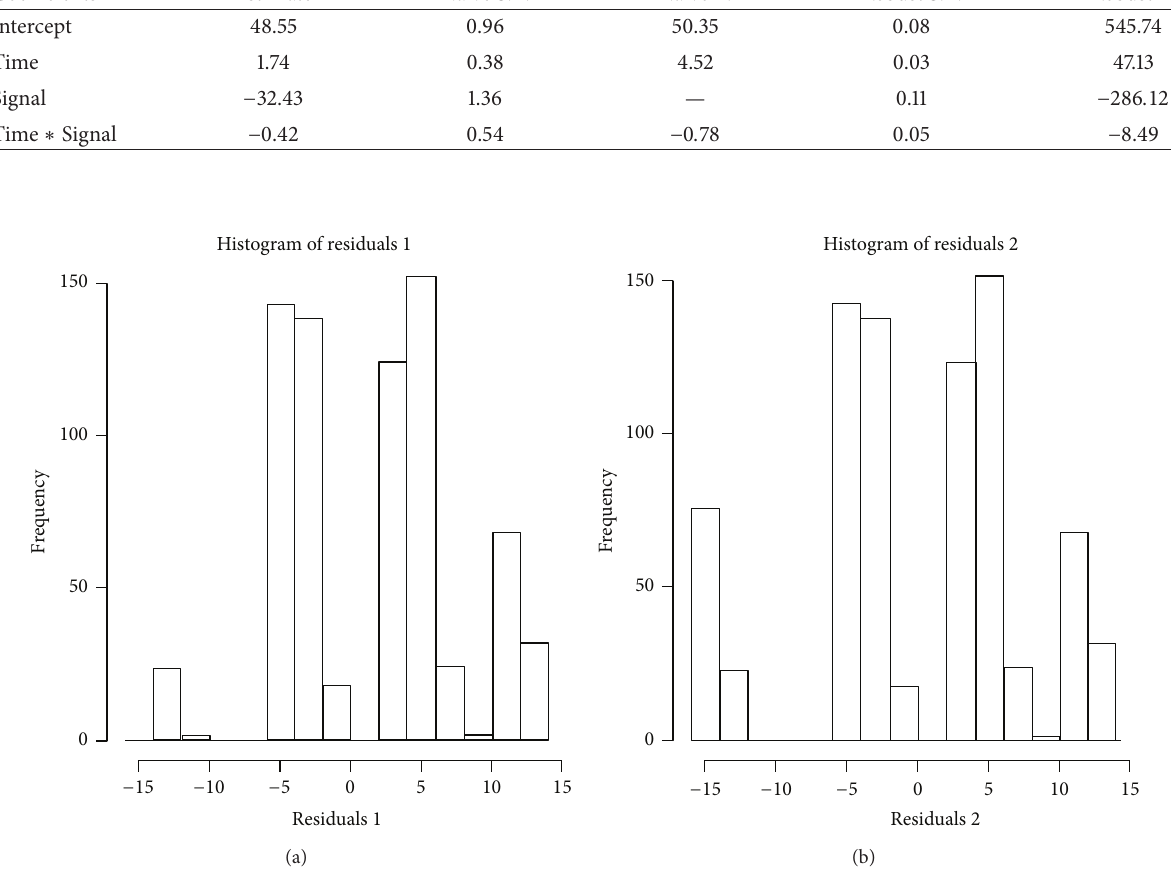
Figure 4: Comparing residuals of the two models.